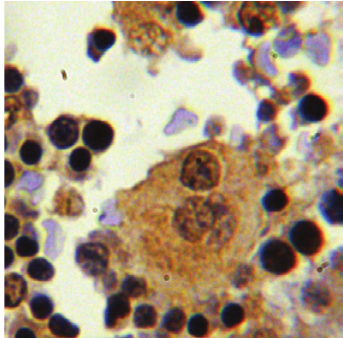
FIGURE 5- Photomicrograph of the liver of a newborn, showing reactivity to CD34 in megakaryocytes, with objective lens of